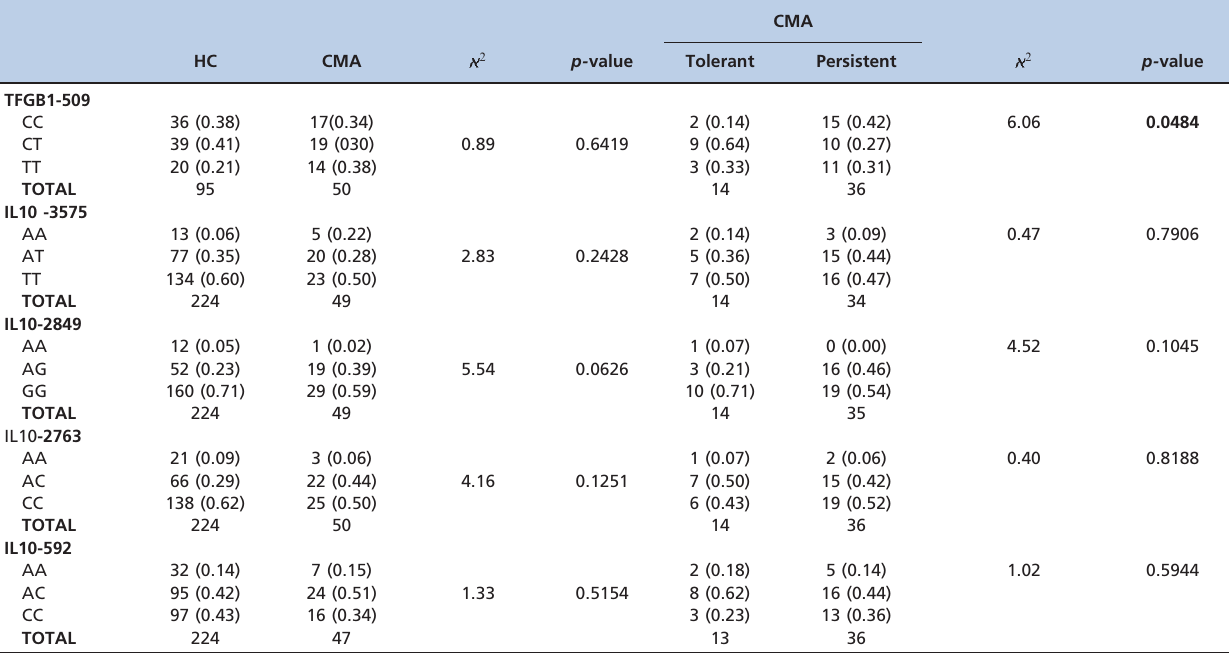
Supplementary Table 1 - Genotype frequency of TGF b 1 -509T/C, IL10 -3575A/T, IL10 -2849 A/G, IL10 -2763 C/A and IL10 - 592A/C, comparing children with cow’s milk allergy with healthy individuals and comparing the tolerant form with the persistent form in CMA patients.